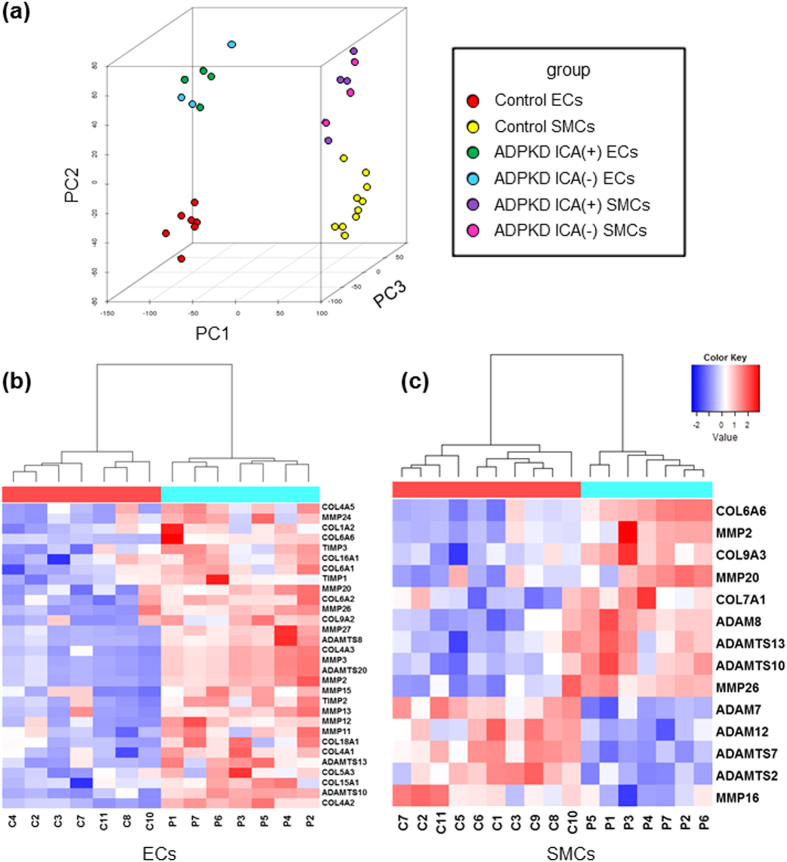
Altered Gene Expression Profiles of Vascular Endothelia and Smooth Muscle Cells Differentiated from ADPKD-iPSCs.(a) The gene expression profiles of vascular endothelia (ECs) and smooth muscle cells (SMCs) derived from ADPKD- and control-iPSCs were analyzed using a principal component analysis (PCA). The first, second and third principal components’ contribution ratios were 0.404, 0.103 and 0.036, respectively. (b,c) The expression levels of multiple genes responsible for extracellular matrix metabolism were altered in ECs (b) and SMCs (c) derived from ADPKD-iPSCs compared with those derived from control-iPSCs. Genes with P-values less than 0.05 were listed and heat maps were generated. The z-scores were calculated from the average and standard deviation of all scores. High and low scores are indicated by red and blue, respectively. Microarray analysis was performed with one sample for each cell line in (a–c). PC, principal component; ICA, intracranial aneurysm.